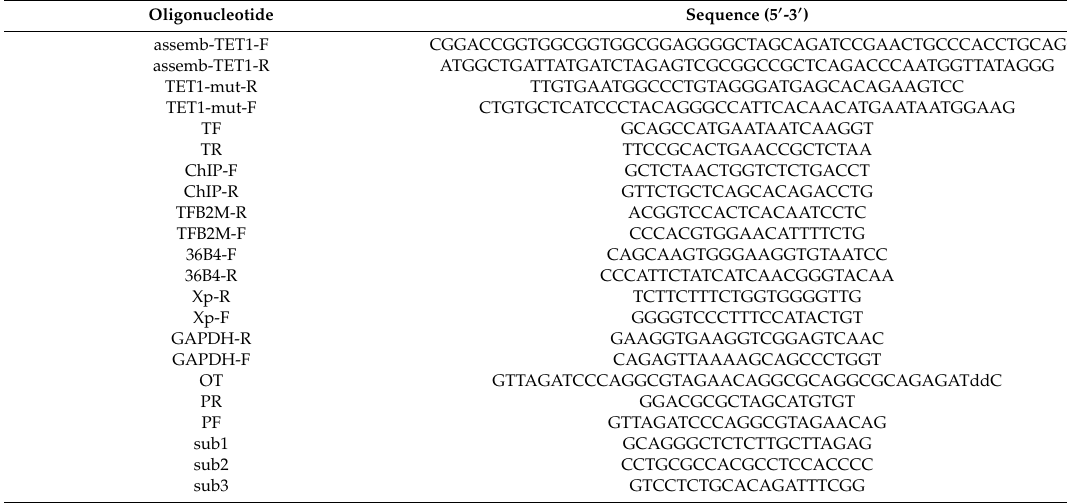
Table 1. Oligonucleotide